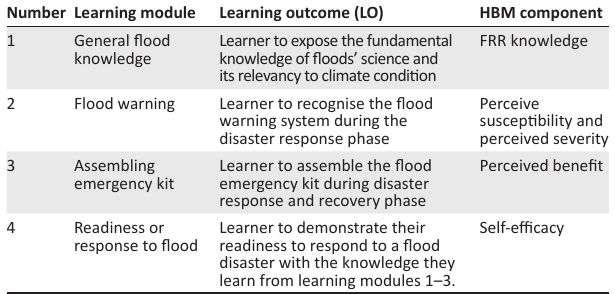
TABLE 1: Learning module for the flood-risk education intervention programme integrated into health belief model framework. Number Learning module Learning outcome (LO)